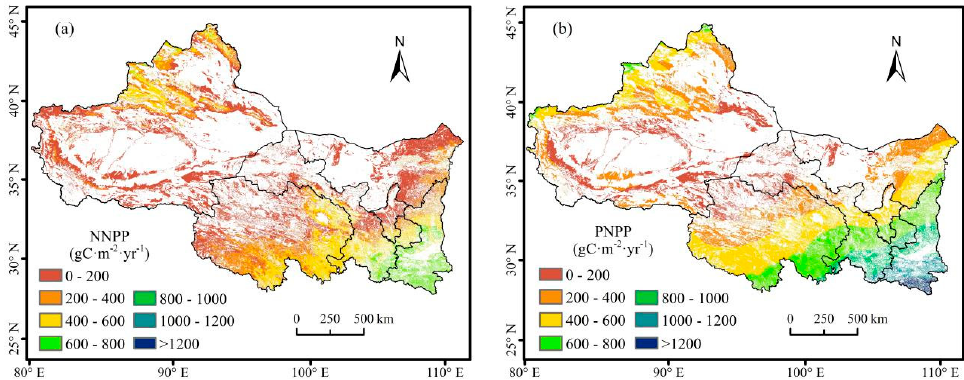
Figure 8. Spatial distribution of annual mean NNPP and PNPP during 2001–2017.